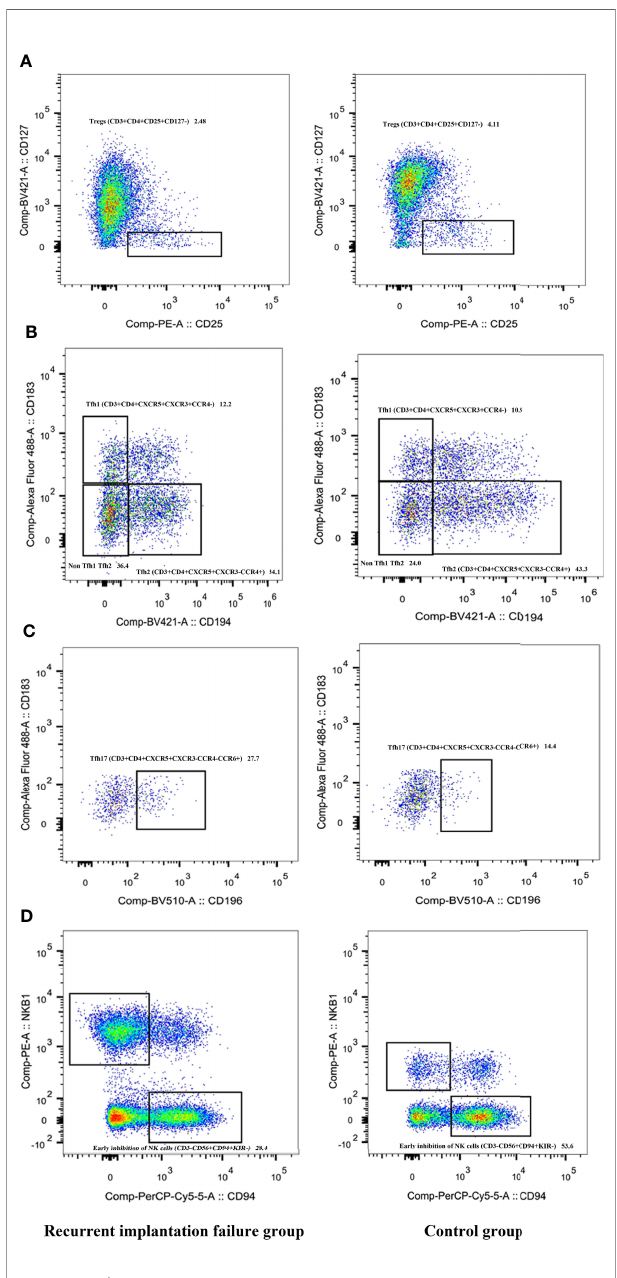
FIGURE 1 | Comparison of Tregs (A) , Tfh1 (B) , Tfh2 (B) , Tfh17 (C) , and early inhibitory NK cells (D) between the RIF and control groups. RIF, recurrent implantation failure; NK, natural killer; Tregs, regulatory T; Tfh, T follicle